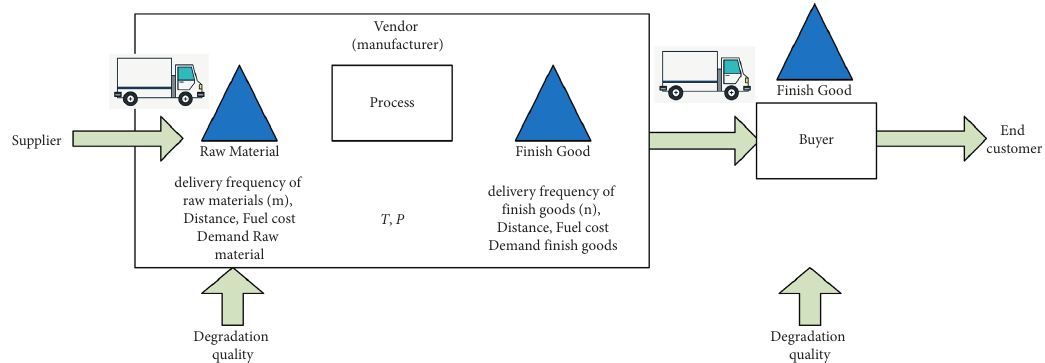
Figure 1: Characteristics of the